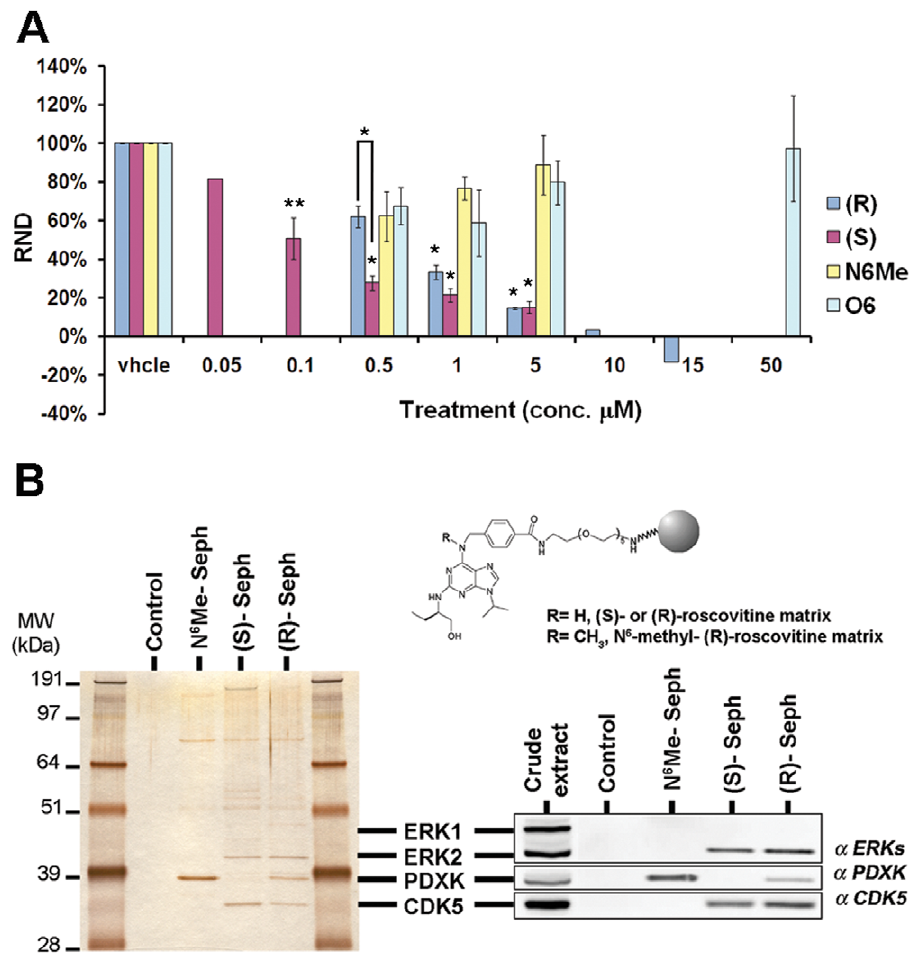
Figure 3. (S)-roscovitine neuroprotective effects are at least in part mediated by CDKs. ( A ) Neuroprotective effects of roscovitine analogs were assessed using an in vitro model of excitotoxicity. Mixed hippocampal cultures were grown for 10 div and exposed to KA (200 m M) for 5 hrs and to roscovitine stereoisomers or kinase inactive analogs added at the same time as the toxic agent. Beneficial effects of roscovitine on KA-induced neuronal death were assessed by phase contrast observation and PI-staining. Relative neuronal death (RND) following KA treatment was measured at different concentrations of (R)-roscovitine [vhcle (n total=322 neurons), 0.5 (n=222), 1 (n=398), 5 (n=392), 10 (n=80), and 15 (n=83) m M], (S)- roscovitine [vhcle (n=766), 0.05 (n=76), 0.1 (n=272), 0.5 (n=511), 1 (n=528), and 5 (n=479) m M], N 6 Me-roscovitine [vhcle (n=326), 0.5 (n=199), 1 (n=163), and 5 (n=173) m M], and O 6 -roscovitine [vhcle (n=391), 0.5 (n=174), 1 (n=180), 5 (n=240), and 50 (n=75) m M]. While both (R) and (S) stereoisomers displayed significant dose-dependent beneficial effect on KA-induced neuronal death, the kinase- inactive roscovitine analogs, N 6 - methyl-(R)-roscovitine and O 6 -(R)-roscovitine, did not exhibited any neuroprotective effect in vitro . Note the significantly increased neuroprotective activity of (S)-roscovitine compared to the (R) stereoisomer at 0.5 m M. ( B ) Affinity chromatography purification of roscovitine targets in the adult rat brain. Total brain extract (500 m g) of one healthy mouse was loaded on immobilized (S)-, (R)-, and N 6 -methyl-(R)-roscovitine (N6Me), as well as on ethanolamine beads (control without inhibitor). The beads were extensively washed and the bound proteins analyzed by SDS-PAGE followed by silver staining ( left ) and Western blotting ( right ) against Erk1/2, PDXK, and CDK5. Note that, as previously described in [30,31], only N 6 -methyl-(R)-roscovitine and (R)-roscovitine bind pyridoxal kinase (PDXK) whereas Erk2 and CDK5 bind to both (S) and (R) stereoisomers of roscovitine but not to N 6 -methyl- (R)-roscovitine. * p , 0.01 ** p , 0.05, t -test.